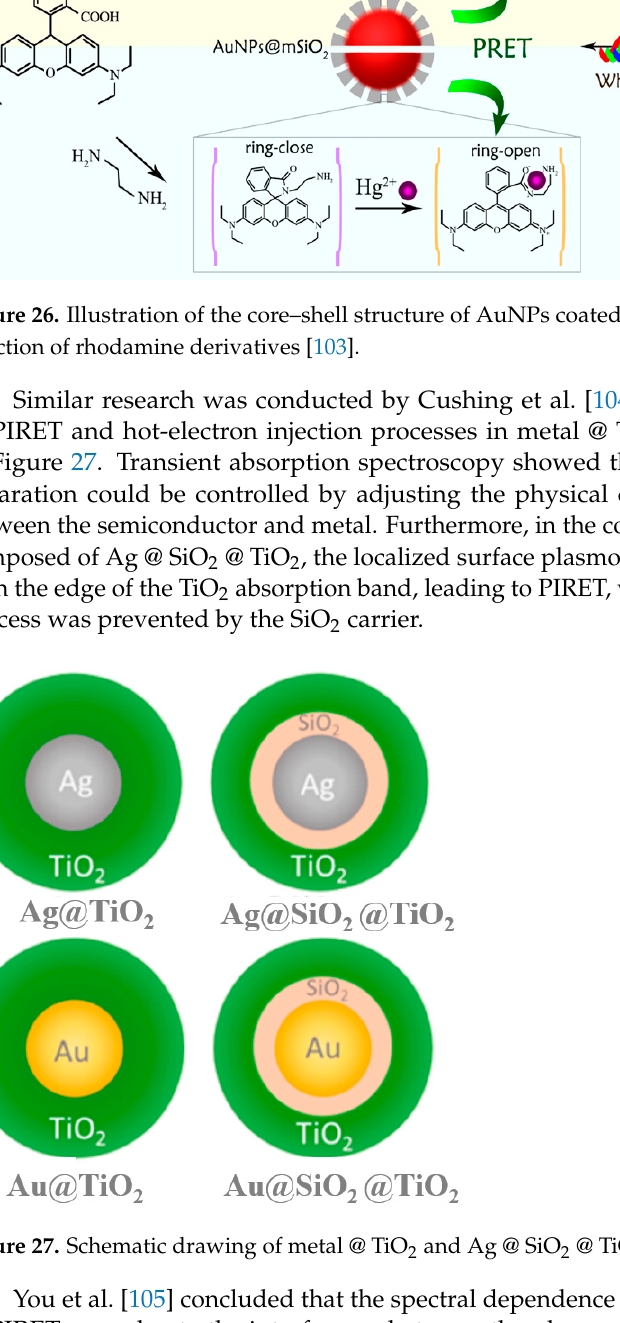
2 and Ag @ SiO 2 @ TiO 2 structure